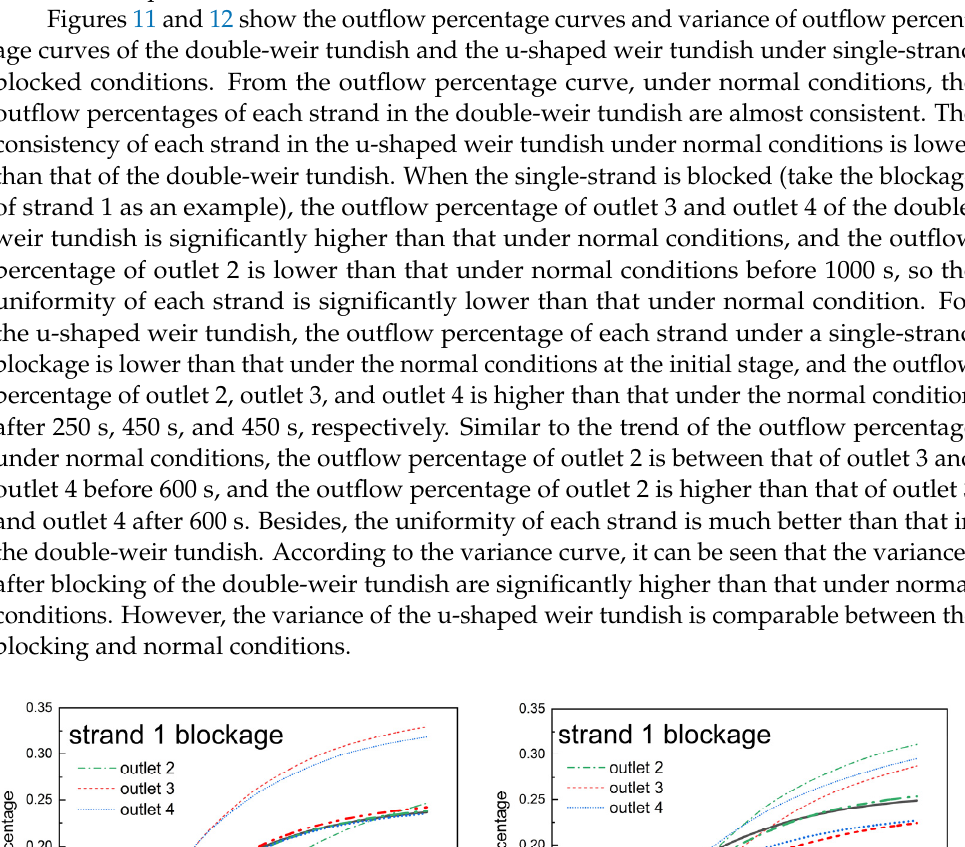
( b ) Figure 12. Variance of outflow percentage of four-strand tundish under single-strand blockage and normal conditions: ( a ) double-weir tundish, ( b ) u-shaped weir tundish. A further analysis of time average variance of outflow percentage is given in Table 3. For the double-weir tundish, the value increases from 8.74 × 10 − 6 to about 2 × 10 − 3 when a strand is blocked. For the u-shaped weir tundish, the values are 2.36 × 10 − 4 , 2.76 × 10 − 4 , and